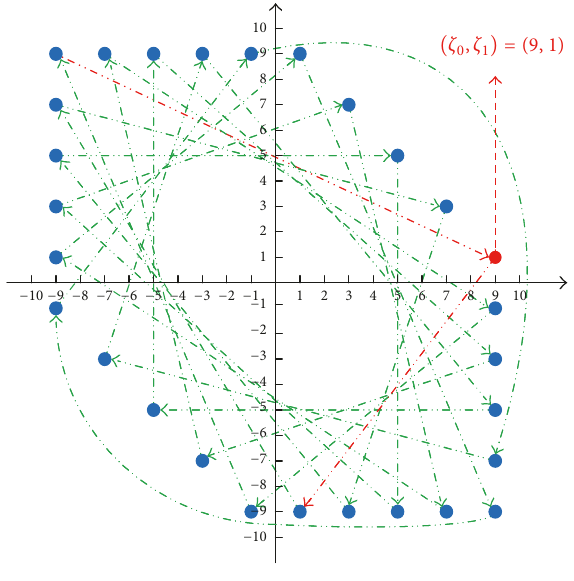
Figure 1: The orbit of 𝜁 with 𝜌 = 1